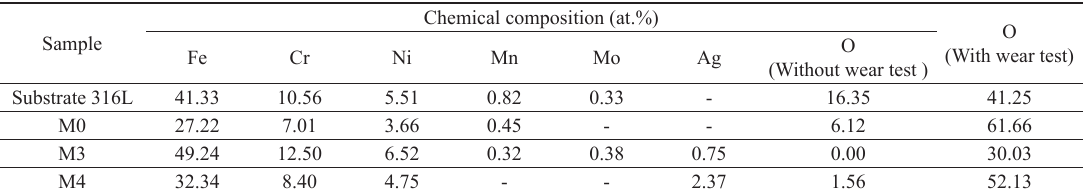
Chemical composition (at.%)